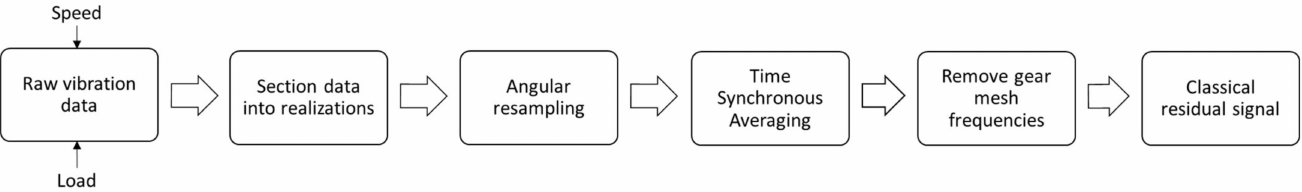
Figure 8. Flowchart of obtaining the classical residual